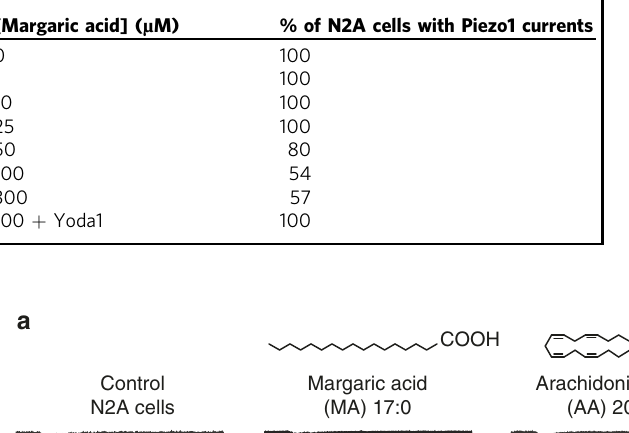
Table 1 Proportion of N2A cells that display Piezo1 currents after MA